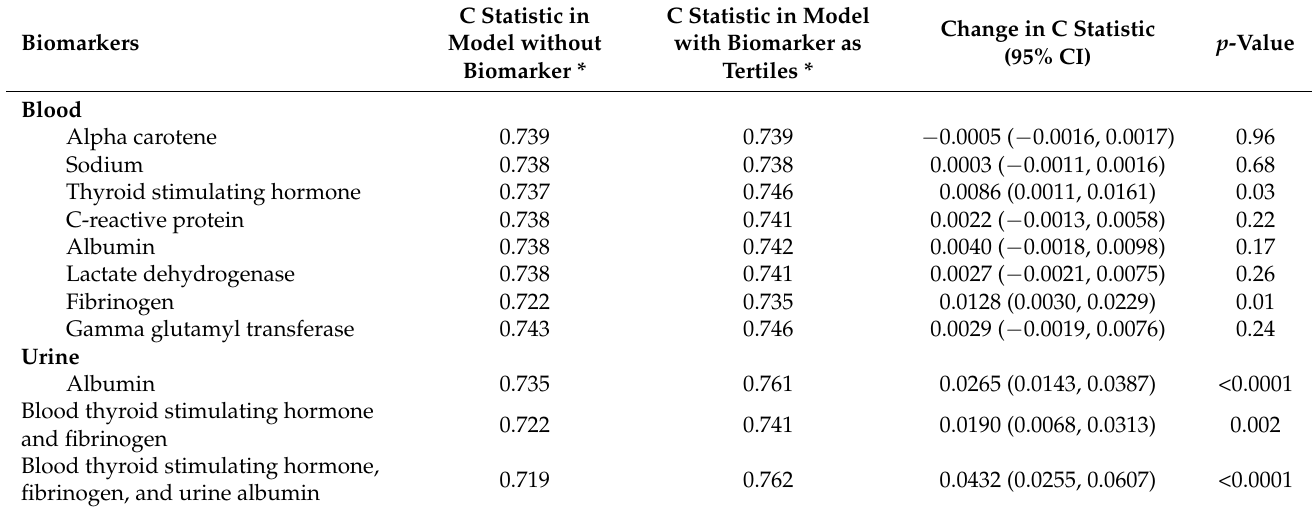
Table 3. Improvements in predictive values with the addition of different biomarkers to